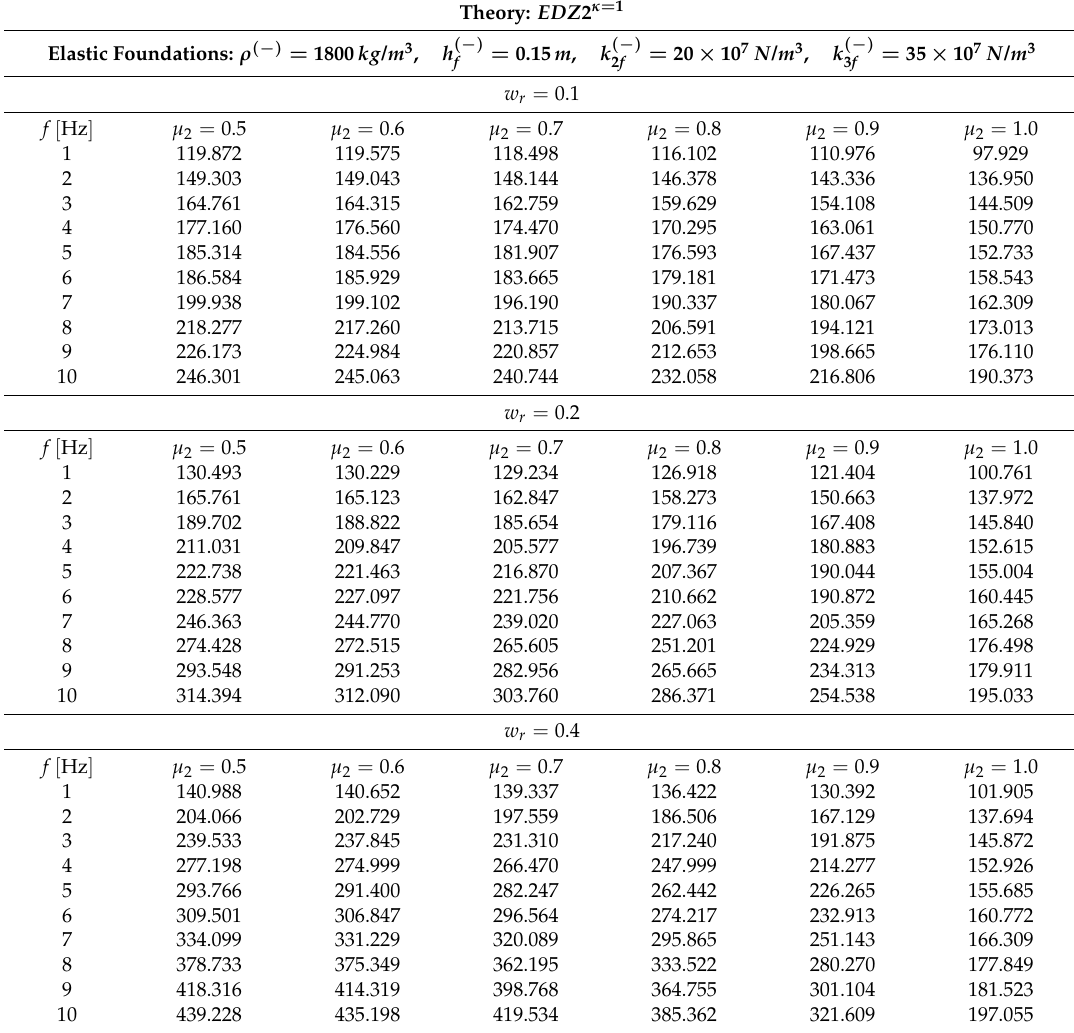
Table 19. First ten natural frequency variations for EDZ2 κ = 1 theory of a CCFF helicoidal surface (Figure 4c) reinforced by CNTs distributed as in Figure 5c for different mass fractions w r when varying the parameter of agglomeration µ 2 with µ 1 = 0.5. The Chebyshev-Gauss-Lobatto grid distribution was employed, with I N = 31, I M =